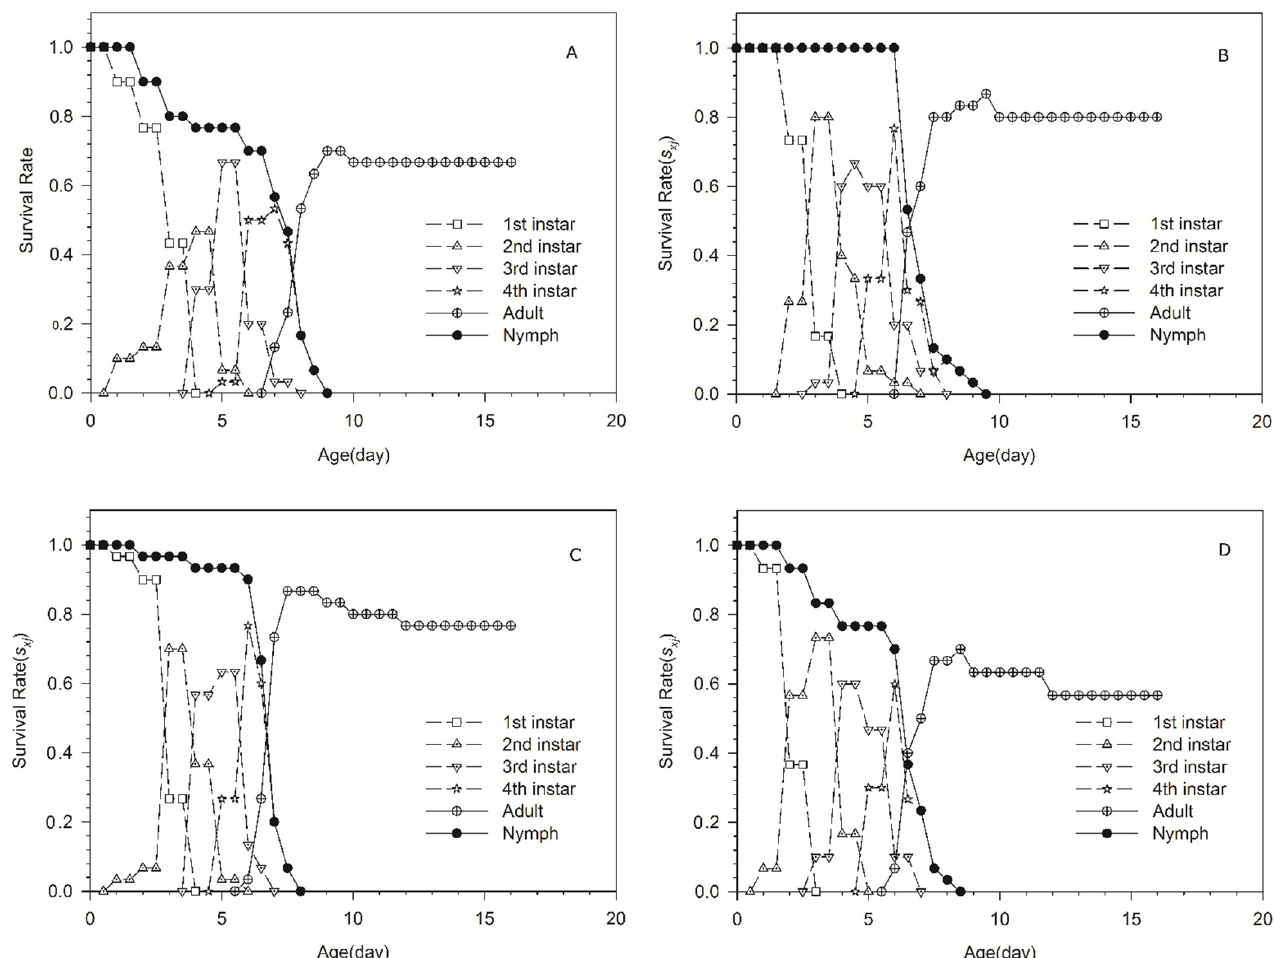
Figure 1. The age-stage survival rates of four Schizaphis graminum acclimated populations. ( A ) ‘98-10-19’-acclimated population; ( B ) ‘98-10-30’-acclimated population; ( C ) ‘186Tm39’-acclimated population; ( D ) ‘186Tm47’-acclimated